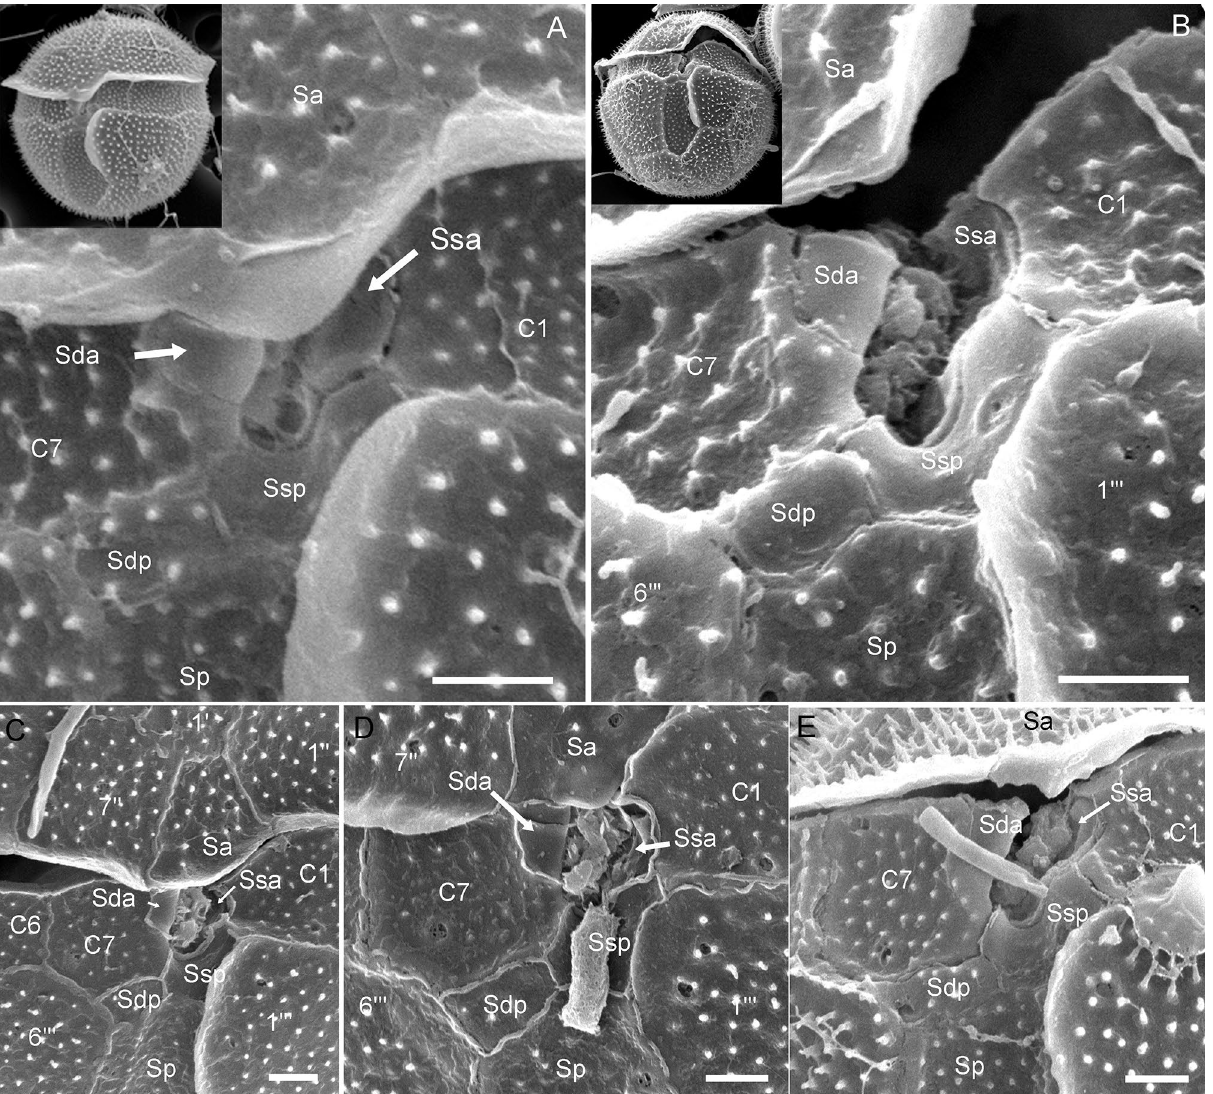
Figure 5. Scanning electron micrographs of Fensomea setacea , gen. & sp. nov . (GeoB*184). ( A – E ) Detailed view of the sulcal area. Abbreviation of sulcal plates: Sa anterior sulcal, Sda right anterior sulcal, Sdp right posterior sulcal, Sp posterior sulcal, Ssa left anterior sulcal, Ssp left posterior sulcal. Scale bars = 1